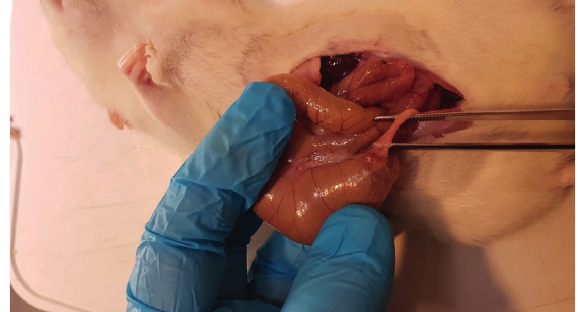
Figure 2: Macroscopic adhesion score 1 case from the 3% glycerol